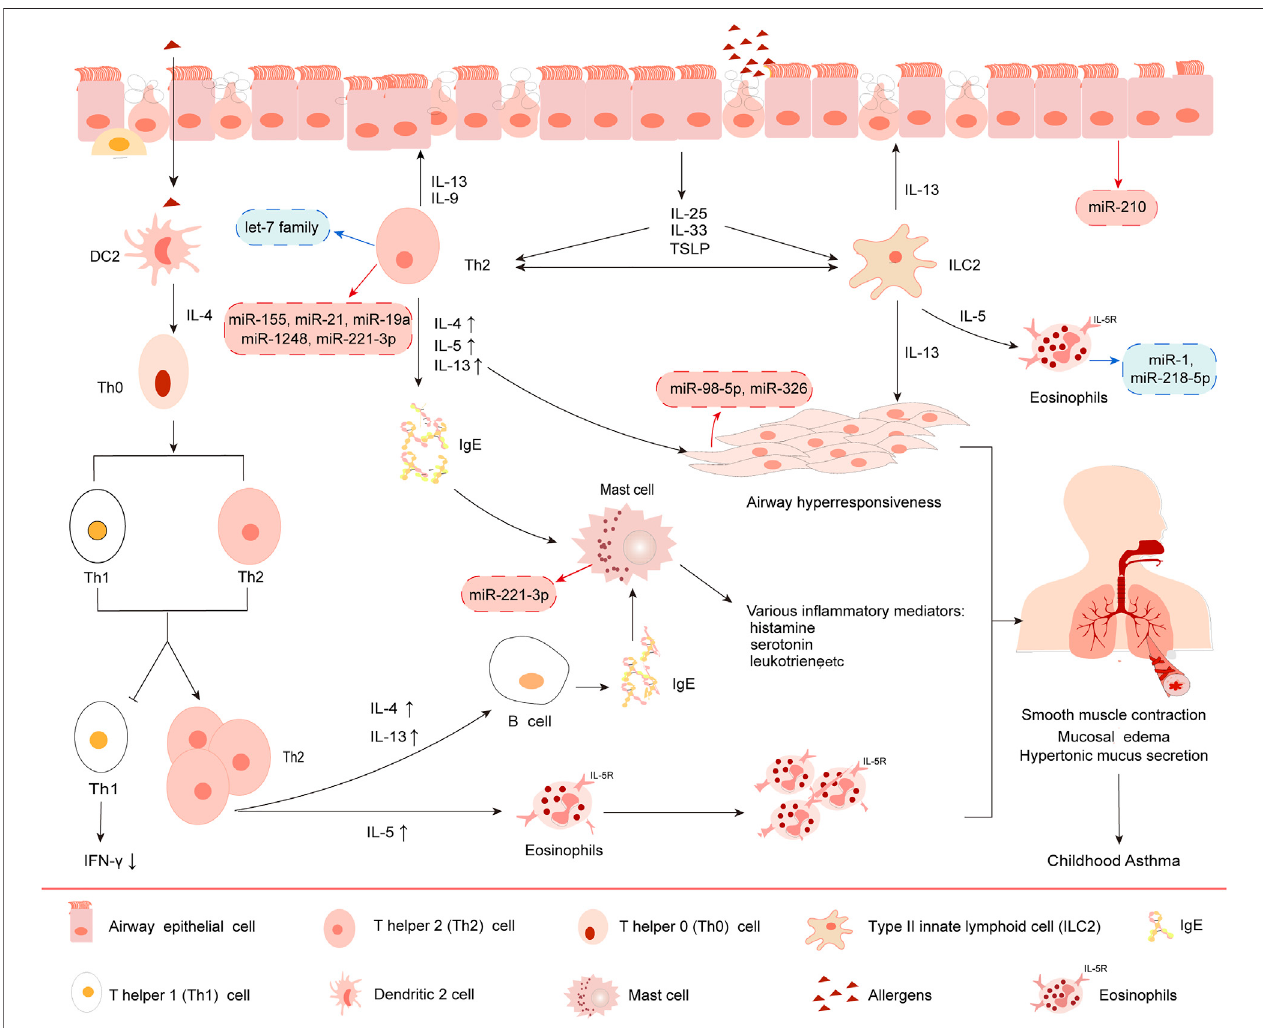
FIGURE2| ImmunopathogenesisofTh2-typeasthma.1)UnderIL-4induction,dendritic2(DC2)cellpromotesthedevelopmentofTh0cellstoTh2,resultinginTh1 (decreased secretion)/Th2 (increased secretion) cell dysfunction. 2) Upon stimulation by allergens, bronchial epithelial cells release IL-25, IL-33 and TSLP, which in turn activates group IIinnatelymphoid cells(ILC2) and Th2cells. 3) Subsequently, Th2cells release Th2cytokines such asIL-4, IL-5and IL-13,rather than Th1 cellsproduce IFN- γ and TNF- β , causing a balanced skewed Th2 cellular immune response. 4) IgE eventually induces rapid onset allergy and cytokines release induced by eosinophils, mast cells and other immune cells, leading to airway in fl ammation. 5) Moreover, different miRNAs have different effects on the above processes. The red boxes in the picture show typical miRNAs that exert upregulated function in asthma. The blue boxes show miRNAs that exert downregulated